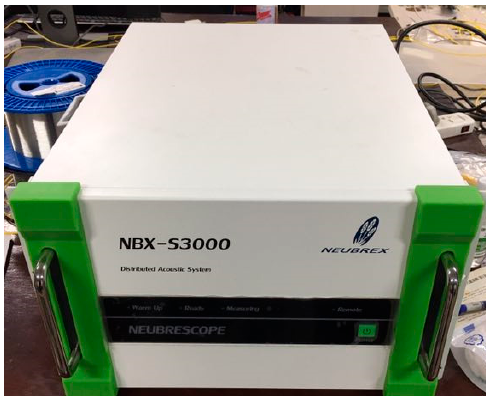
Figure 6. Image of Φ -OTDR instrument.